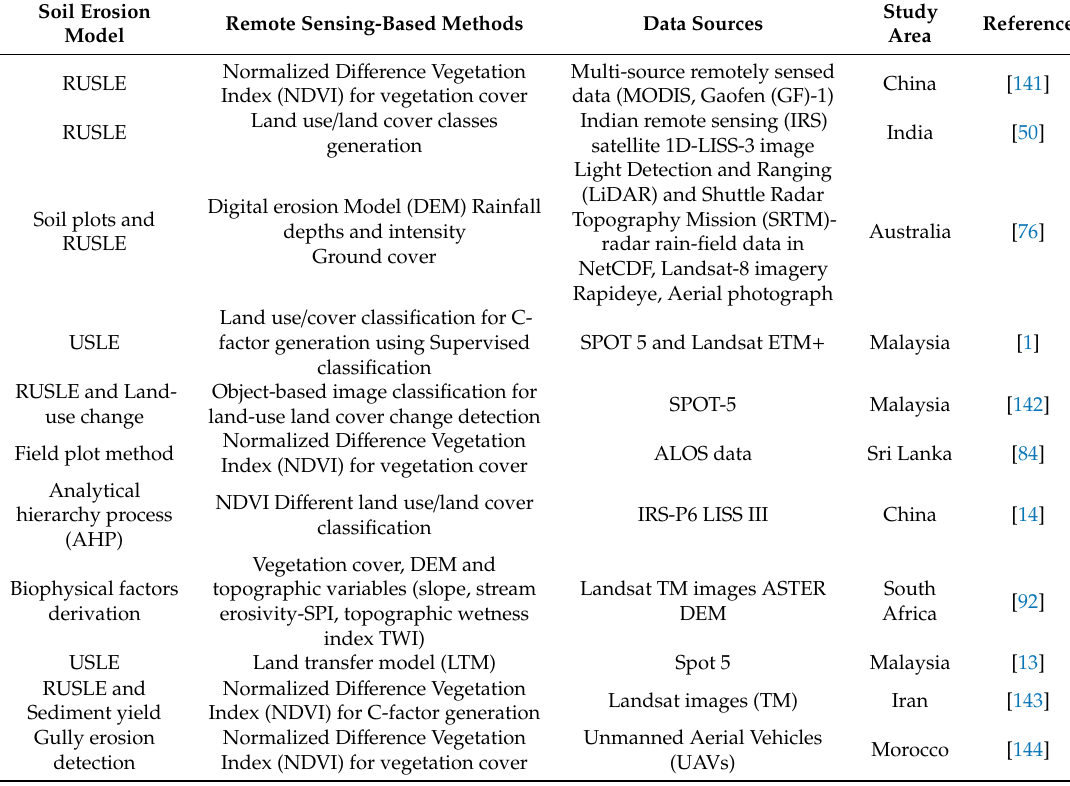
Table 3. Integrated soil erosion modelling approaches with remote sensing-based